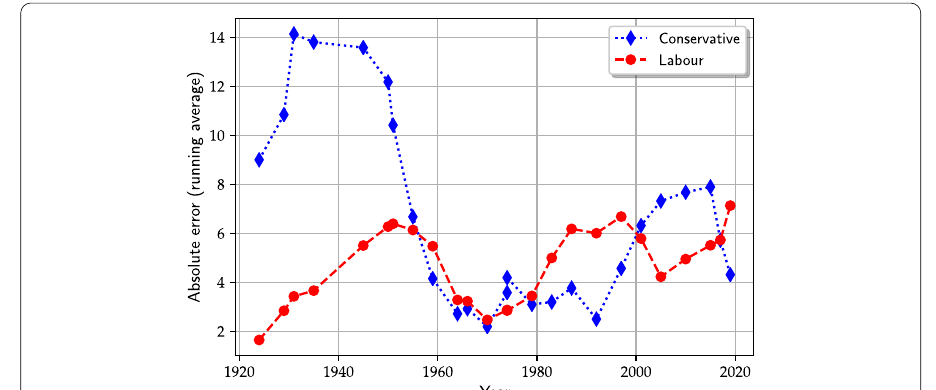
Fig. 3 Absolute error between prediction and reality for the UK elections, running average over the last 5